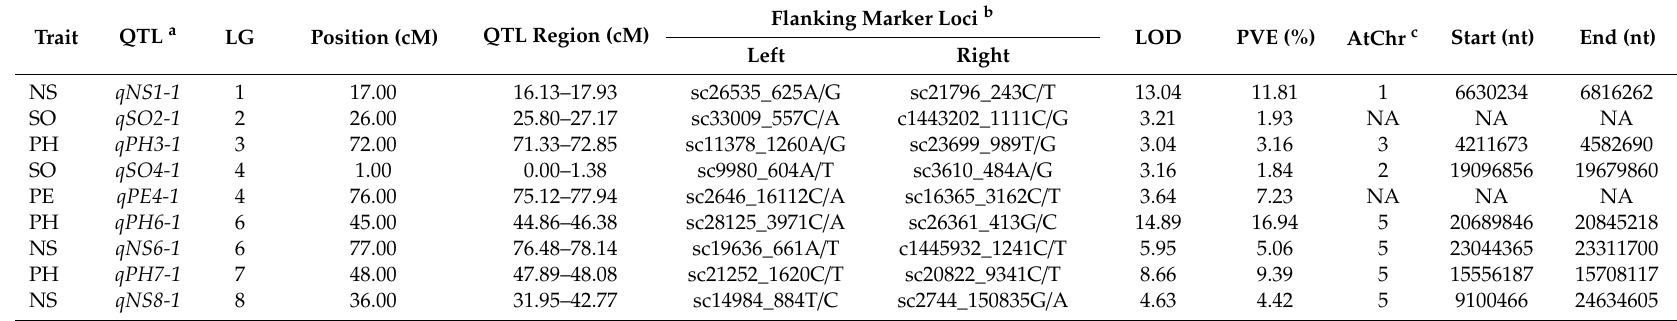
Table 4. List of the nine QTLs for number of stems per plant (NS), stem growth orientation (SO), plant height (PH), or perenniality (PE), their respective position on the eight field cress linkage groups (LGs), as well as the genomic region that they span, the flanking SNP markers of each QTL, their LOD score, and the percentage of phenotypic variance that they explained (PVE). The homologous regions in A. thaliana chromosomes (AtChr), corresponding to the genomic regions spanned by seven of the nine QTLs, are shown in the last three